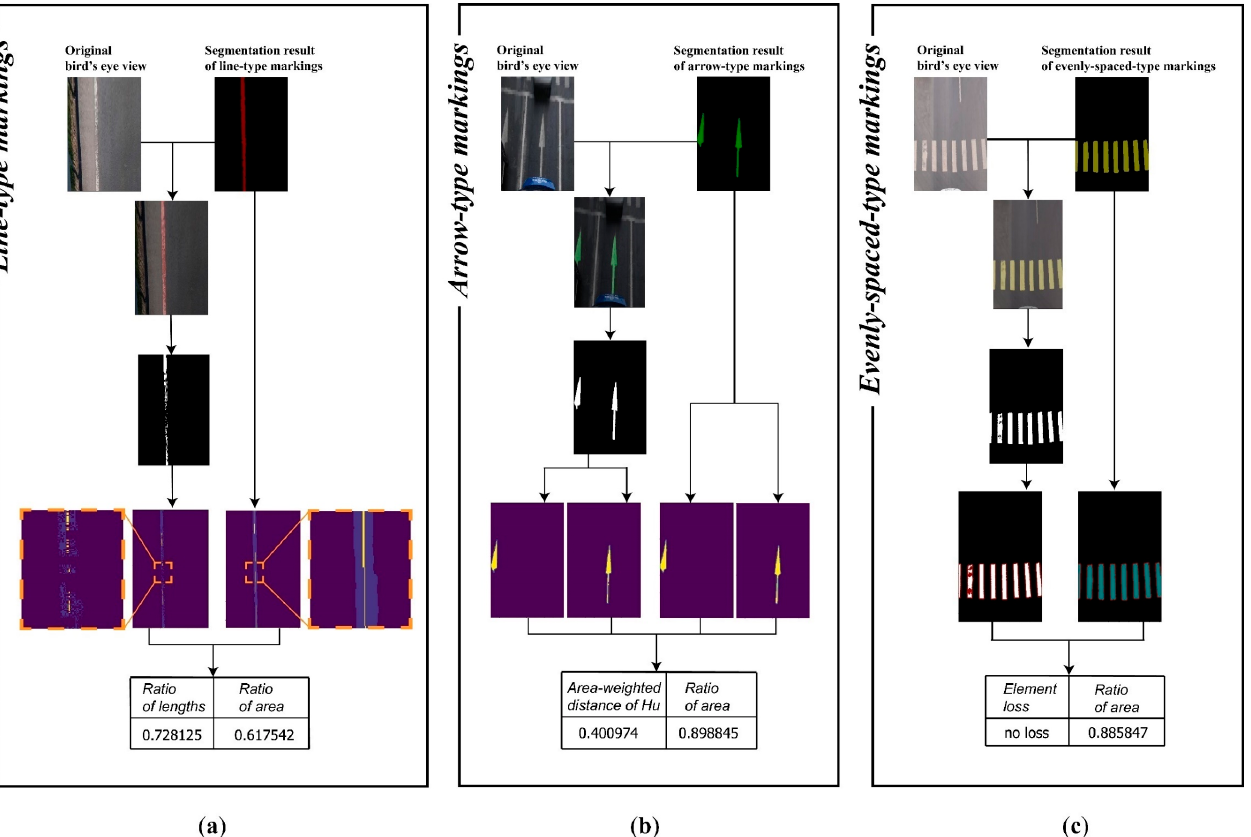
Figure 8. Flowchart of quantitative assessment on defects of three types of pavement markings. ( a ) An example of line-type markings, ( b ) an example of arrow-type markings, ( c ) an example of evenly-spaced-type markings.